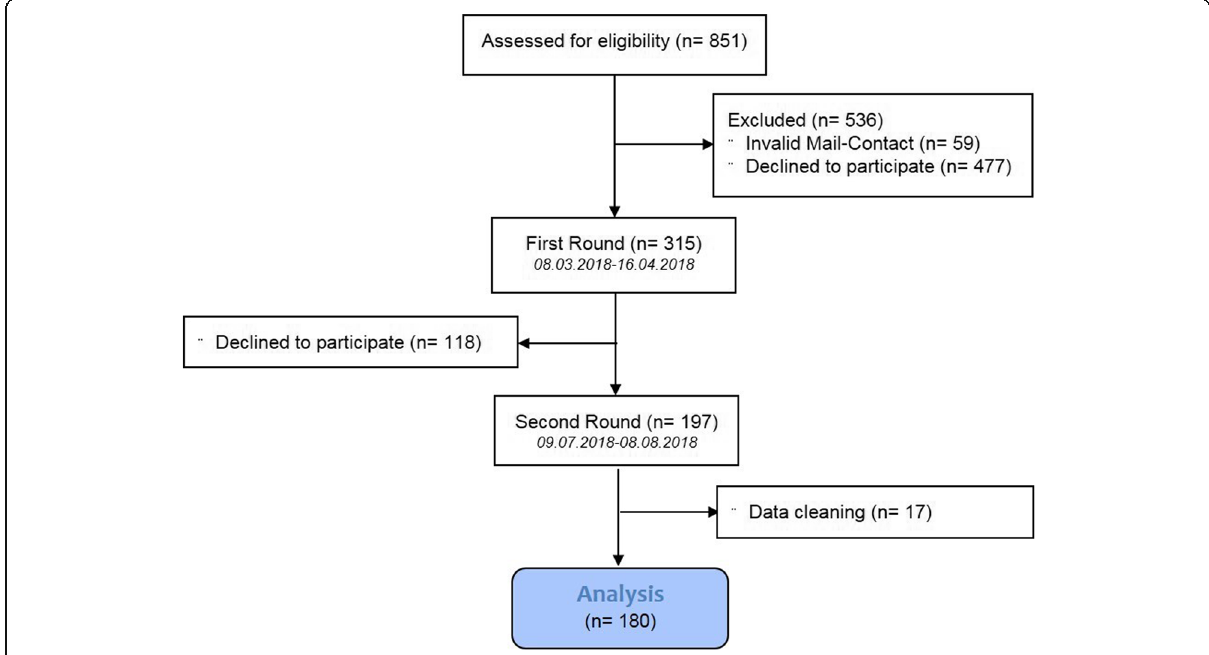
Fig. 1 Graphical representation based on CONSORT flow chart (see